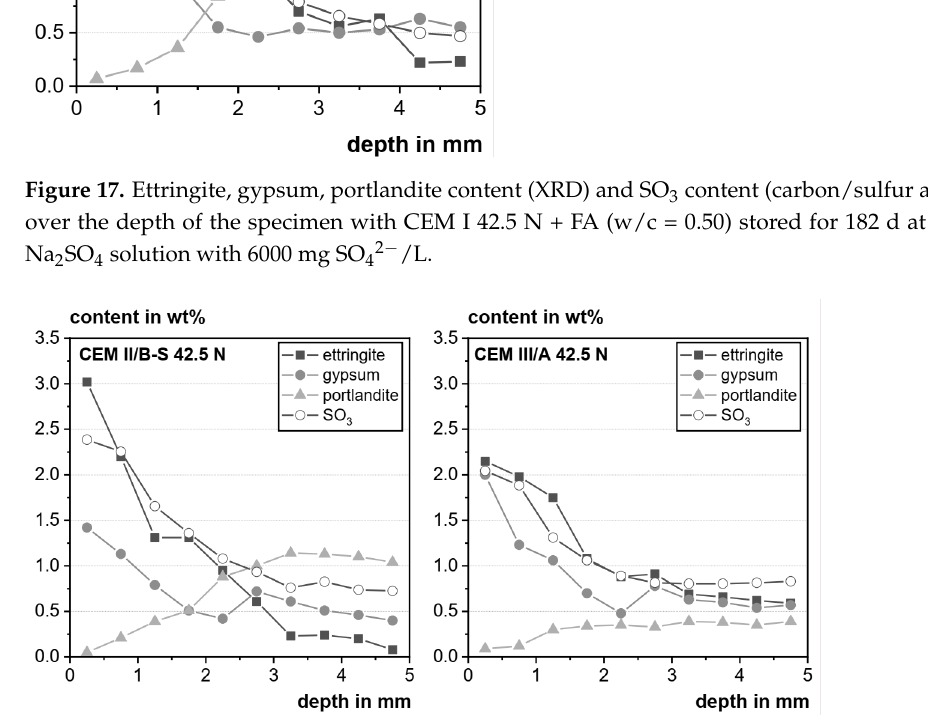
Figure 18. Ettringite, gypsum, portlandite content (XRD) and SO 3 content (carbon/sulfur analysis) over the depth of the specimen with CEM II/B-S 42.5 N and CEM III/A 42.5 N (w/c = 0.50) stored for 182 d at 5 ◦ C in Na 2 SO 4 solution with 6000 mg SO 42 −